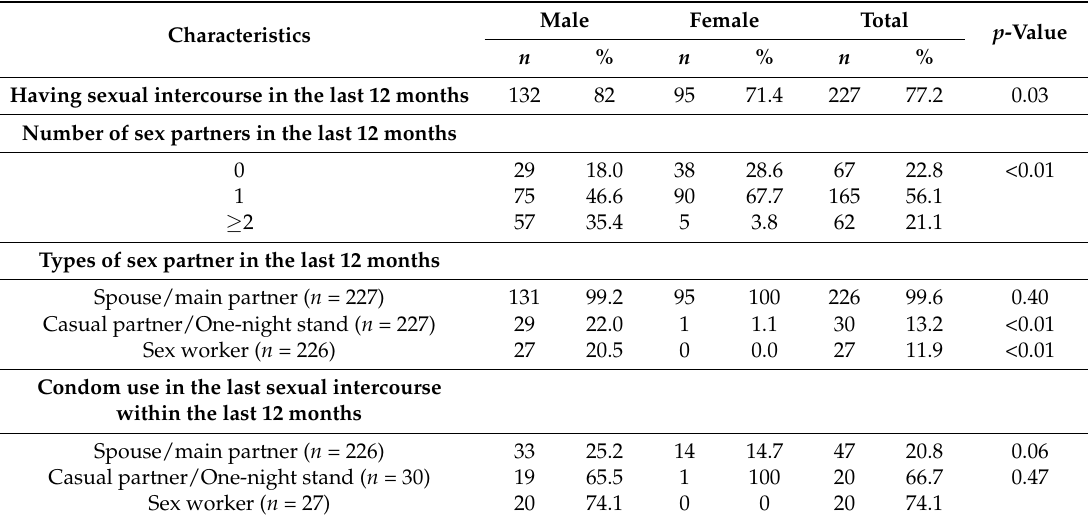
Table 3. Sexual practices among CHB